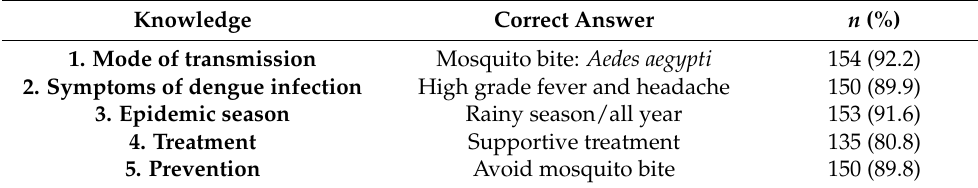
Table 3. Knowledge about dengue